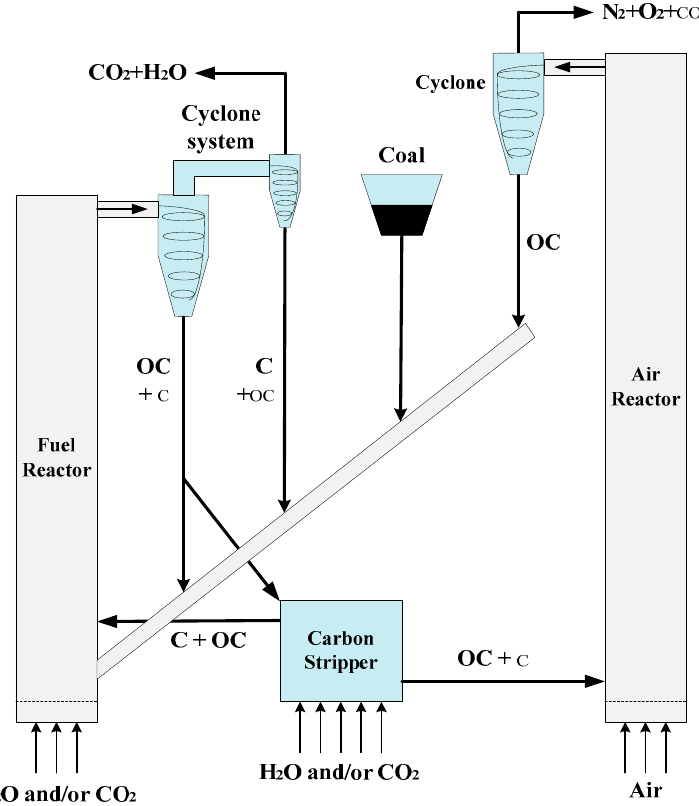
Figure 1. Schematic diagram of in-situ Gasification Chemical Looping Combustion system. Reprinted with permission from references [16,17]. Copyright 2013